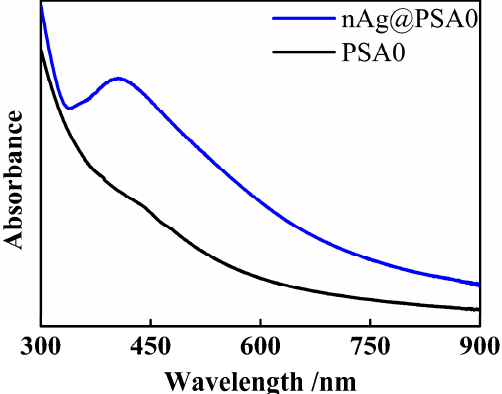
Figure 14. Absorption spectra of PSA0 nanospheres and nAg@PSA composite nanospheres obtained from PSA0 nanospheres.